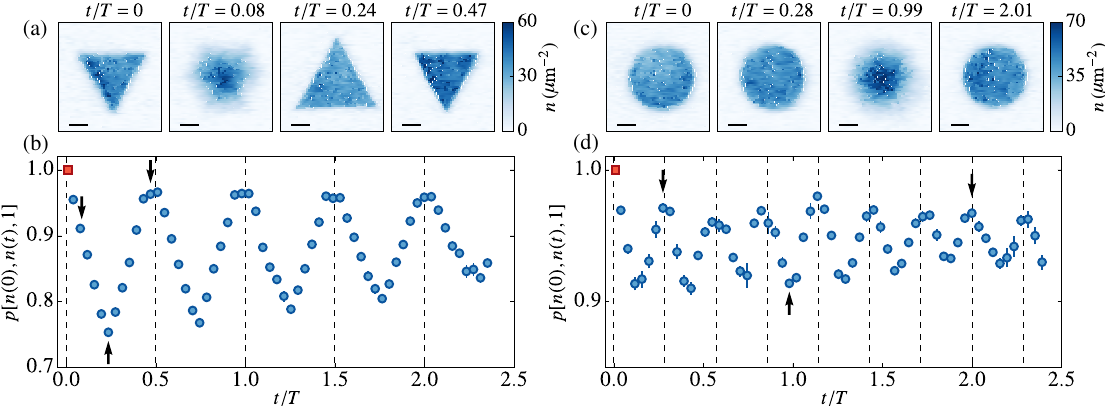
FIG. 5. (a) Density distributions of an initially triangular-shaped cloud at t=T ¼ 0 , t=T ¼ 0 . 08 , t=T ≈ 1 = 4 , and t=T ≈ 1 = 2 . The first and last distributions are close to each other. (b) Scalar product between the initial density distribution of a triangular-shaped cloud (red square) and the density distributions during its evolution in the harmonic trap. The first point is fixed at 1. The dashed lines indicate where t=T is a multiple of 1 = 2 . The shape seems to be periodic of period T= 2 . (c) Density distributions of an initially disk-shaped cloud at t=T ¼ 0 , t=T ≈ 2 = 7 , t=T ≈ 1 , and t=T ≈ 2 . The first two and the last distributions are close to each other. (d) Scalar product between the initial density distribution of a disk-shaped cloud (red square) and the density distributions during its evolution in the harmonic trap. The first point is fixed at 1. The dashed lines indicate where t=T is a multiple of 2 = 7 . The shape seems to be periodic of period 2 = 7 . In (a) and (c), the horizontal black lines represent 10 μ m. In (b) and (d), the black arrows indicate the point corresponding to density distributions shown in (a) and (c), respectively. The error bars represent the statistical error of the